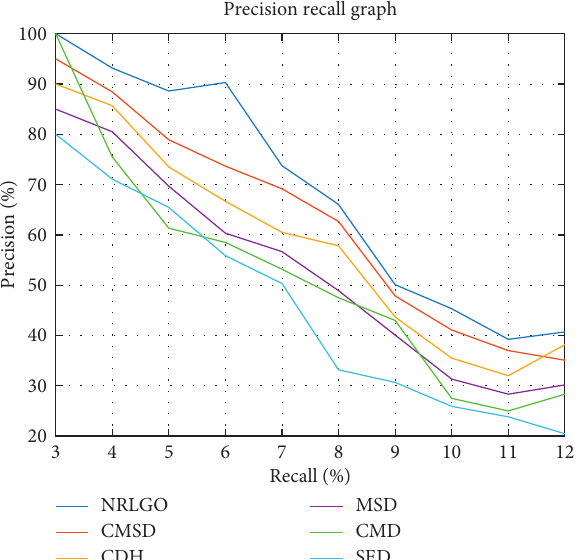
Figure 7: Performance of NRLGO is compared with state-of-the-art descriptors on Corel 5k using precision and recall